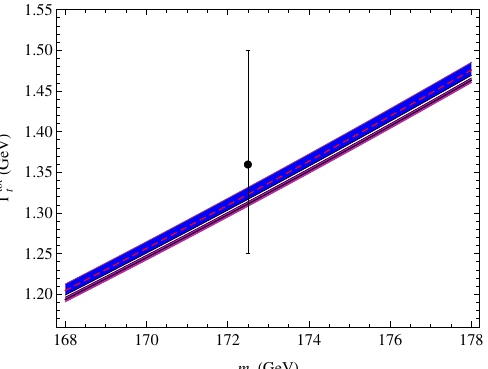
Figure 8. The top-quark total decay width Γ tot versus the top-quark mass m t . The solid line is the t PMC prediction, and the dashed line stands for the conventional prediction. As a comparison, the CMS measured value [83] is also